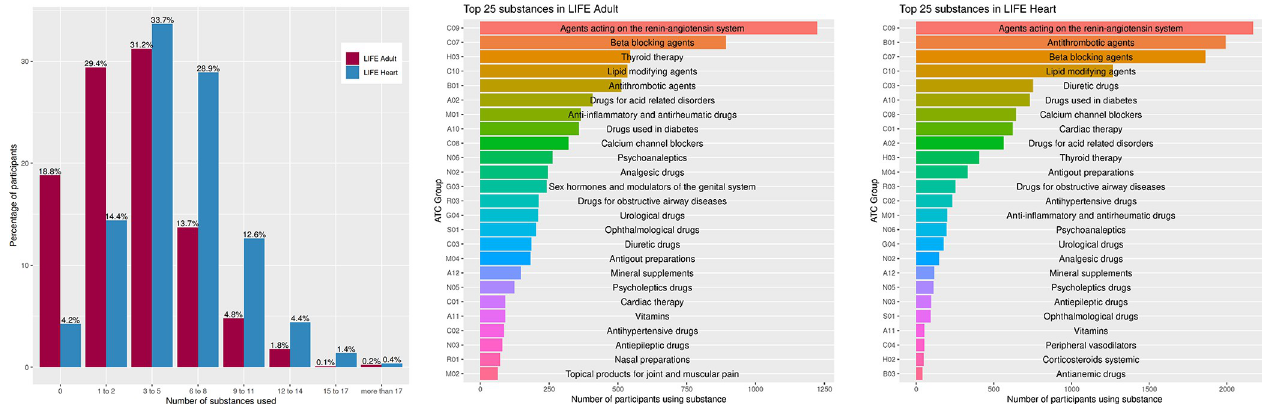
Fig 2. Polymedication of LIFE-Adult and LIFE-Heart participants and most common substances. Top: Polymedication of LIFE-Adult and LIFE-Heart participants, shown by number of active substances consumed. Participants taking no medication were used as control group. Bottom: Most common substances used in both